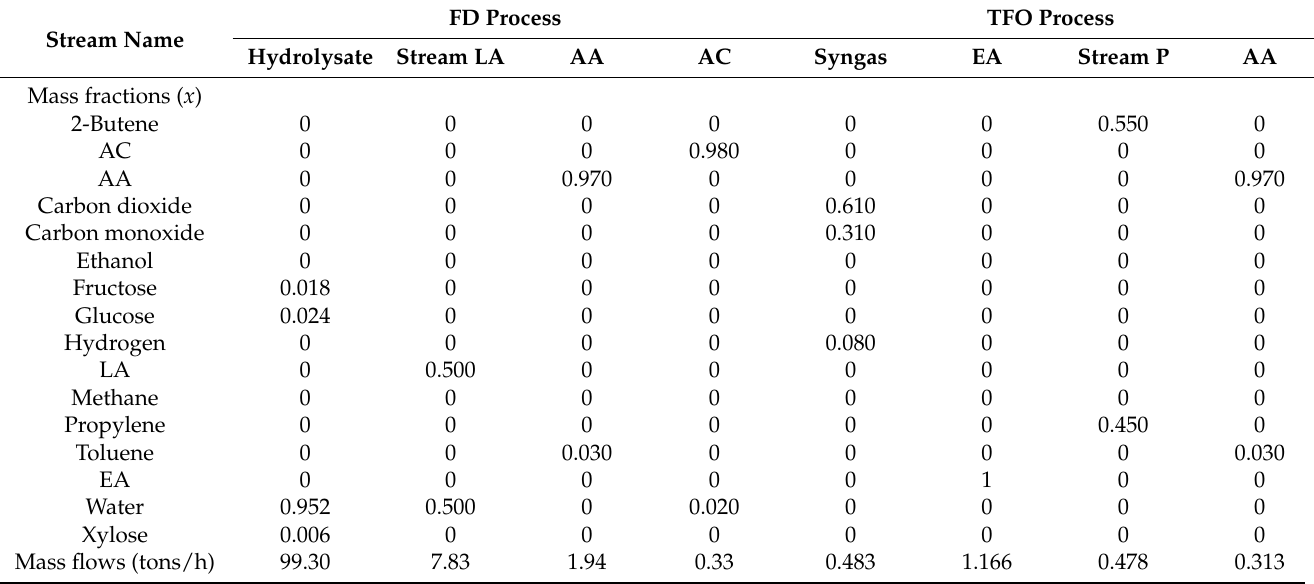
Figure 4. Aspen Plus output for AA production from WAP via the thermochemical–fermentation– oxidation (TFO) pathway (black continuous lines, red dash lines and blue dashed line denote material, heat and work flows, respectively). Table 3. Mass balance results for major streams in the AA production processes.